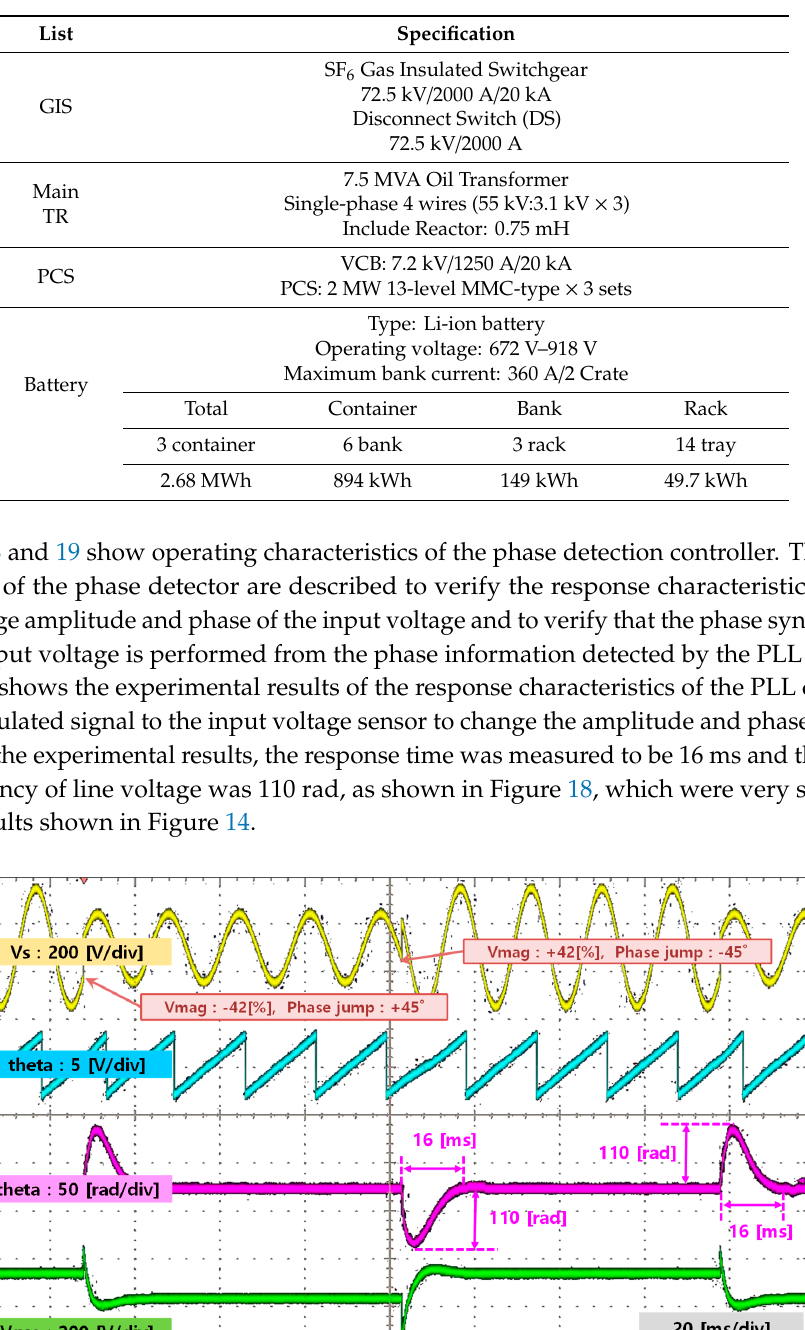
( b ) Yellow: Vs-PT: AC Secondary voltage Yellow: Vs-TR: Catenary Voltage Green: Vs-flt: Controller filtering voltage Green: Vs-PWM: PWM output voltage Pink: Vs-PLL: PLL voltage Pink: theta ( (cid:2016) (cid:3032) ): Phase angle Blue: theta ( (cid:2016) (cid:3032) ): Phase angle Blue: Vs-PLL: PLL voltage Figure 19. Actual system voltage PLL characteristics: ( a ) Phase detection and ( b ) PWM synchronous. Figures 20 and 21 show the operation of the battery balancing algorithm according to the operation state of the PCS and the SOC condition of the battery. To confirm the results of the experiment, PCS operation and battery status information were verified using the PMS. The output voltage of each cell inverter was measured using an oscilloscope. Figure 20a and Figure 21a show the